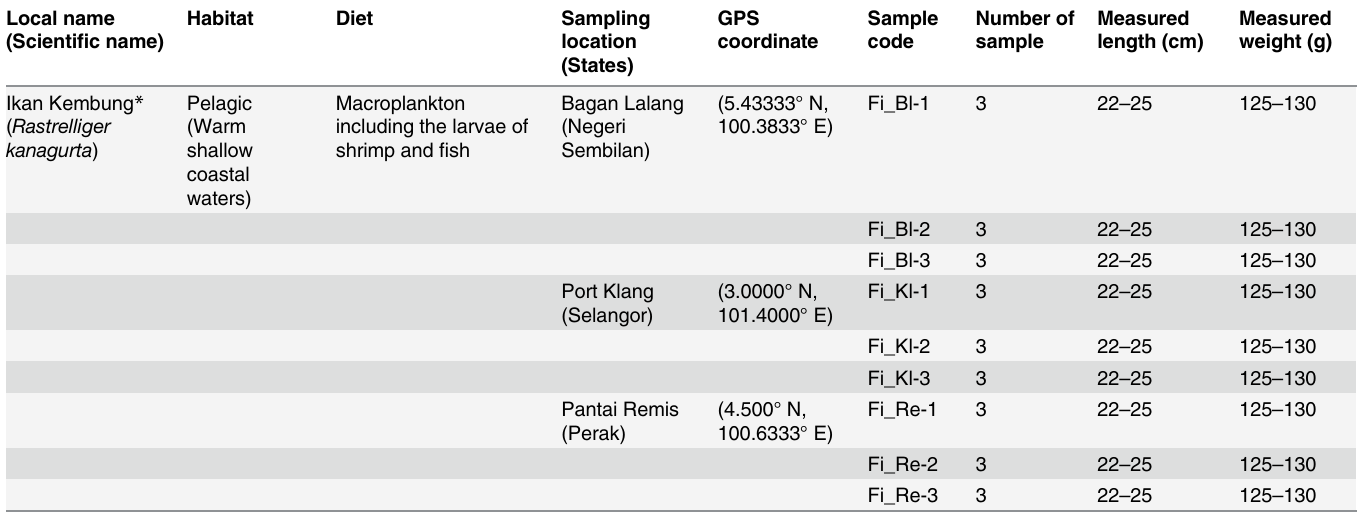
Table 1. Marine fish samples collection data.